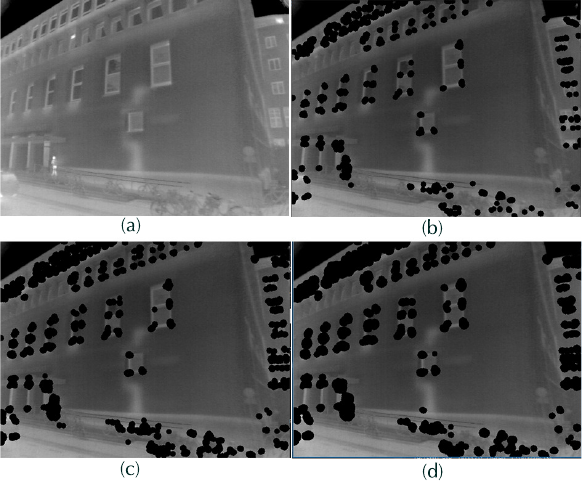
Figure 6. Detected harris keypoints in TIR image. (a) Original image (b) keypoints for test 1. (c) keypoints in test 2. (d) keypoints in test 3.